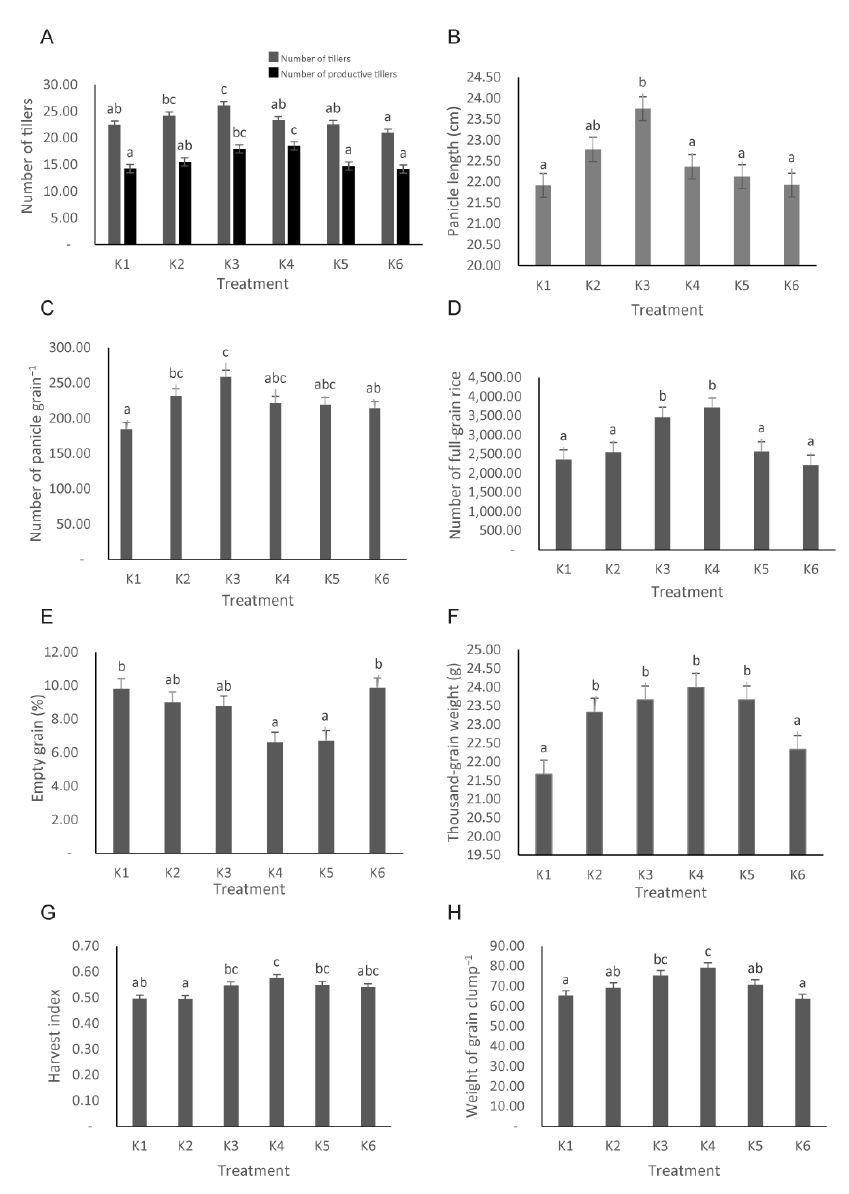
(cid:0) 1 Figure 3 Number of tillers ( A ), panicle length ( B ), number of grains panicle ( C ), number of full grains ( D ), percentage of empty grains ( E ), 1,000-grain weight ( F ), harvest (cid:0) 1 index ( G ), and grain weight clump ( H ). Bars (means (cid:6) standard deviation; n = 3) with different letters are significantly different at LSD